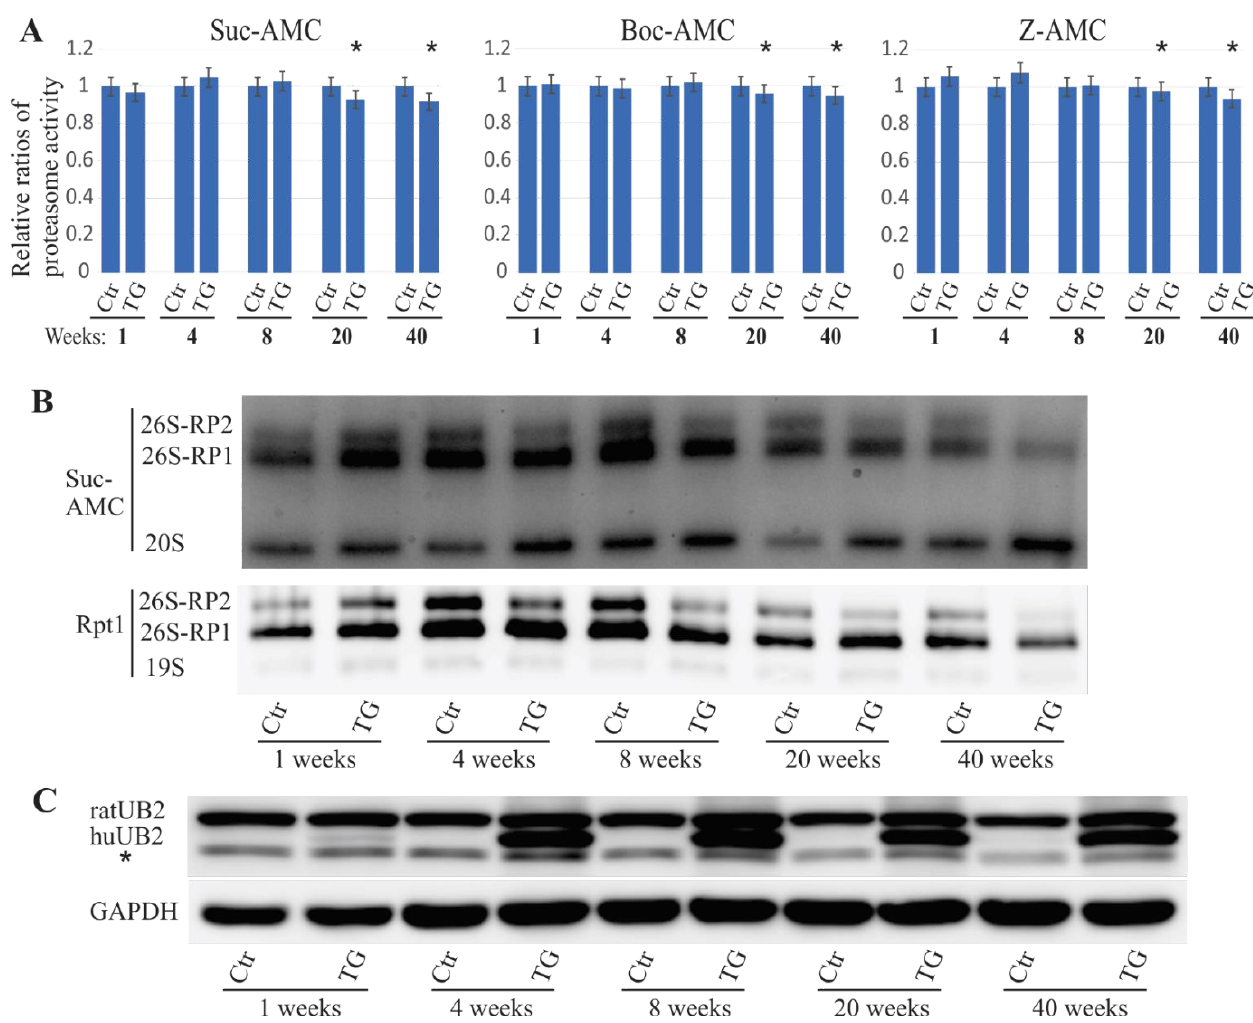
Figure 1. Impaired proteasome assembly in mutant UBQLN2 rats. ( A ). The overall activity of proteasomes was measured using sensitive fluorogenic substrates (Boc-AMC, Suc-AMC, or Z-AMC). The data are reported as the mean ± standard deviation ( N = 4), * p < 0.05. ( B ). The in-gel assay (Suc-AMC) revealed that 26S proteasome assembly was impaired in mutant UBQLN2 rats, and in the immunoblot analysis using the Rpt1 antibody and 3 – 12% NativePAGE. Rat forebrains was homogenized in native protein lysis buffer, and 50 µg of total protein lysates were examined for the analysis. 26S-RP1/RP2: 26S proteasome containing either one or two regulatory subunits. ( C ). Immunoblot by SDS-PAGE showing UBQLN2 expression levels. Of total protein lysates 10 µg were assessed and the GAPDH signal was used as the loading control. RatUB2: endogenous UBQLN2; huUB2: human UBQLN2.